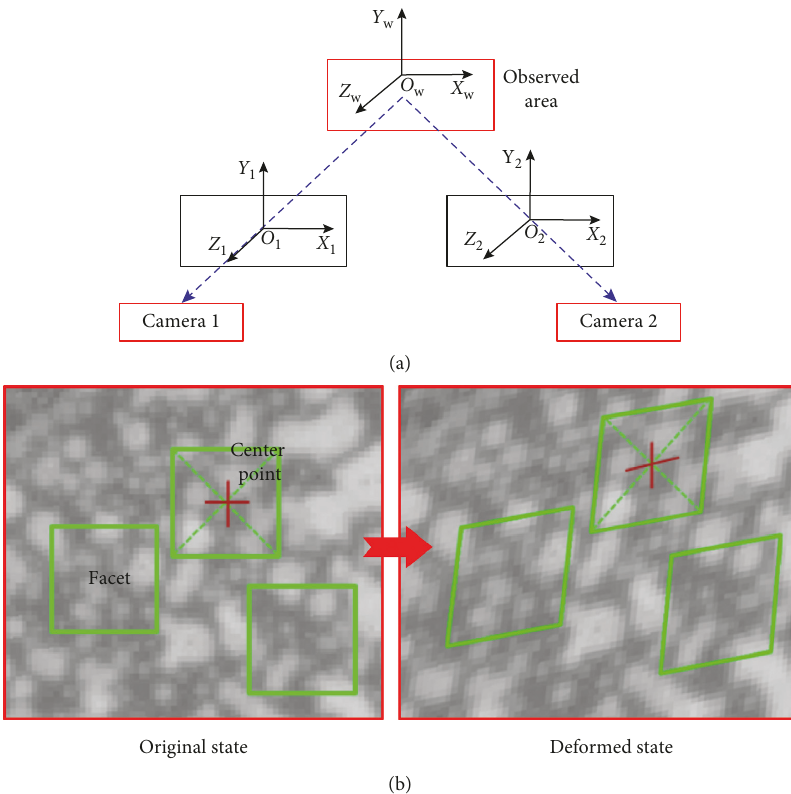
Figure 2: Scheme of the 3D full-field measurement system. (a) DIC measurement diagram; (b) DIC calculation